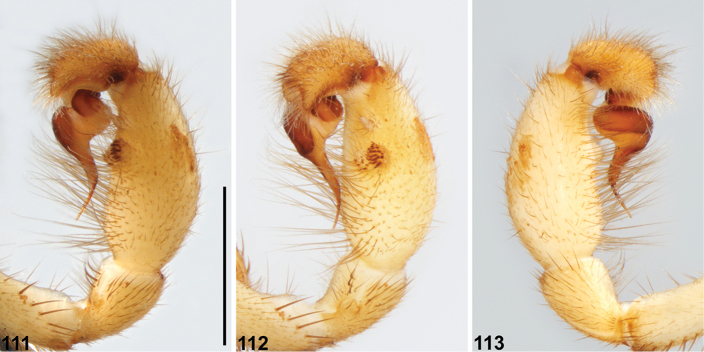

Idiosoma
corrugatum sp. n., male holotype (SAM NN29858) from SW. of Kimba (South Australia; EYB), pedipalp. 111 Retrolateral view 112 Retroventral view 113 Prolateral view. Scale bar 2.0.